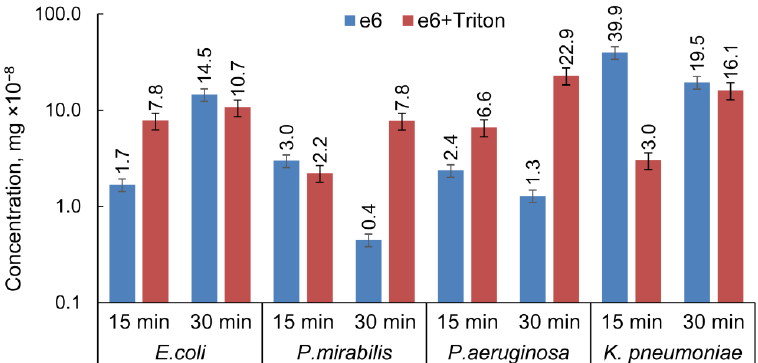
Figure 3. The amount of Fotoditazin taken up by a single bacterial cell of Gram-negative species depending on incubation time and presence of Triton x-100. Bacteria were incubated with photosensitizer (e6) and Triton X-100 for 15 min or 30 min at room temperature in the dark. Before measurement the samples were washed from unbound chemicals.